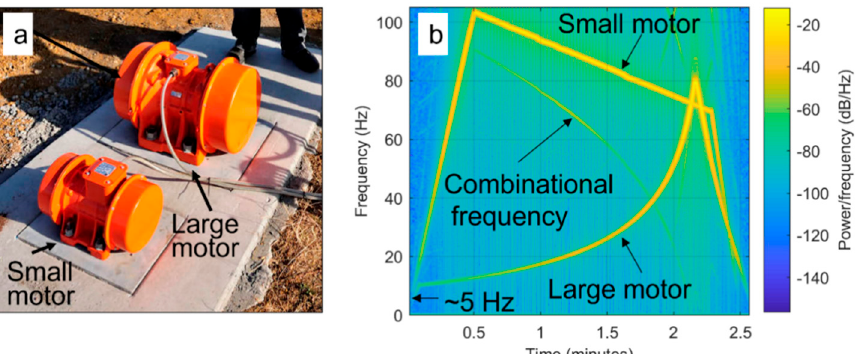
Figure 6. ( a ) Surface orbital vibrator (SOV) installed at the Otway project site. ( b ) Spectrogram of the signal recorded by the reference 3C geophone buried 3 m below the SOV during the production sweep.